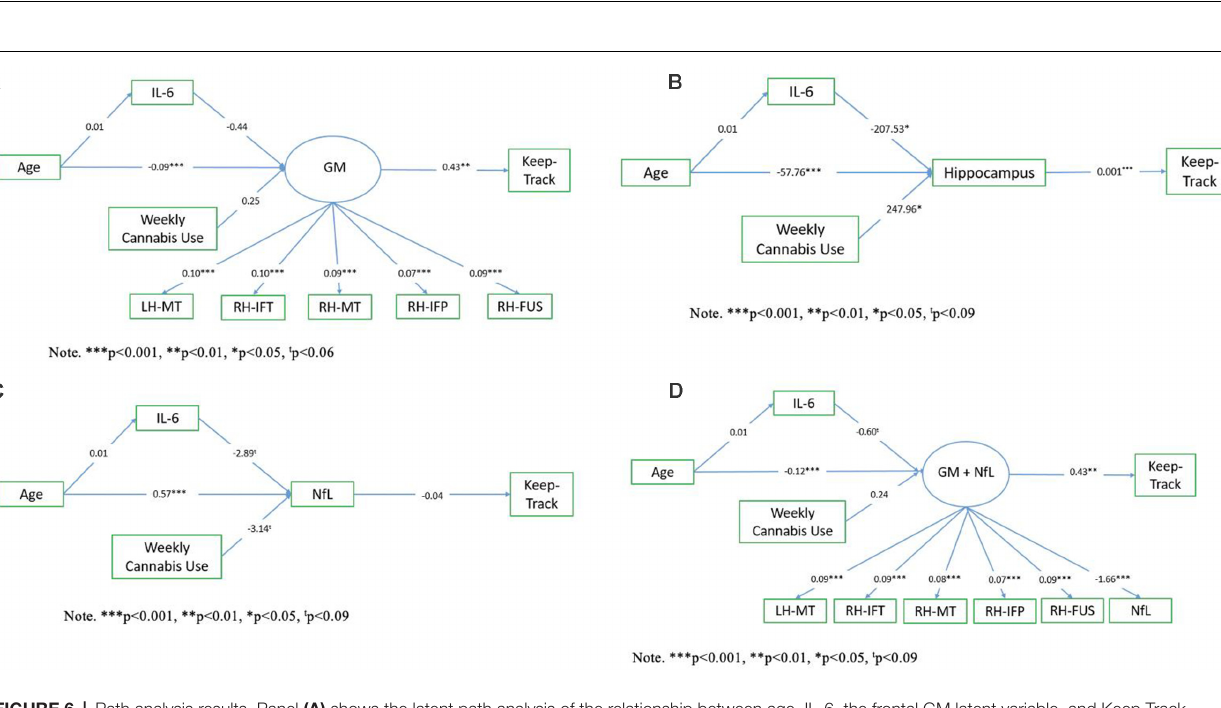
FIGURE 6 | Path analysis results. Panel (A) shows the latent path analysis of the relationship between age, IL-6, the frontal GM latent variable, and Keep Track. Panel (B) shows the latent path analysis of the relationship between age, IL-6, hippocampal volume, and Keep Track. Panel (C) shows the path analysis of the relationship between age, IL-6, Nfl, and Keep Track. Panel (D) shows the latent path analysis of the relationship between age, IL-6, frontal GM, and NfL latent variable, and Keep Track. Note. LH-MT, left hemisphere middle temporal thickness; RH-IFT, right hemisphere inferior temporal thickness; RH-MT, right hemisphere middle temporal thickness; RH-IFP, right hemisphere inferior parietal thickness; RH-FUS, right hemisphere fusiform thickness.